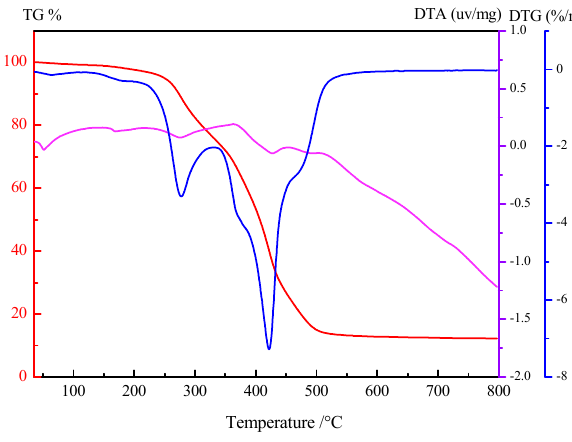
Figure 2. TGA, DTG and DTA curves of MSE-Al.